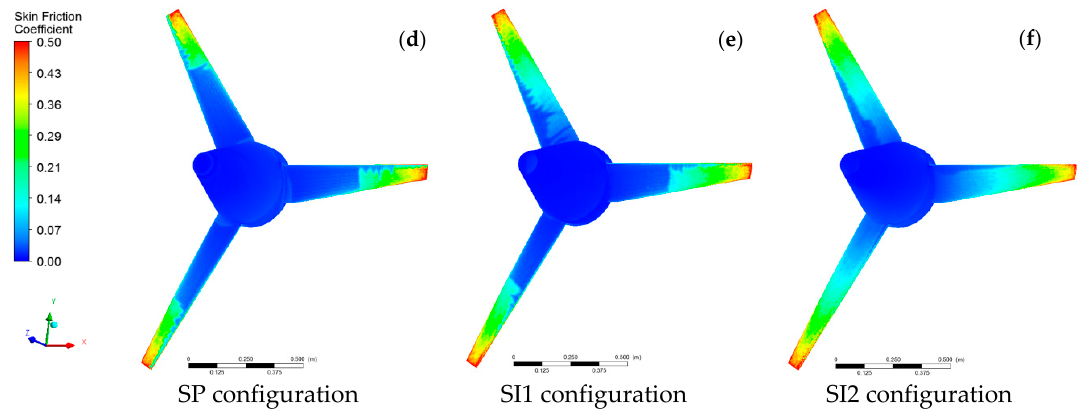
Figure 9. The pressure coefficient ( a – c ) and skin friction coefficient ( d – f ) at the blade’s pressure side in the three considered inclinations.